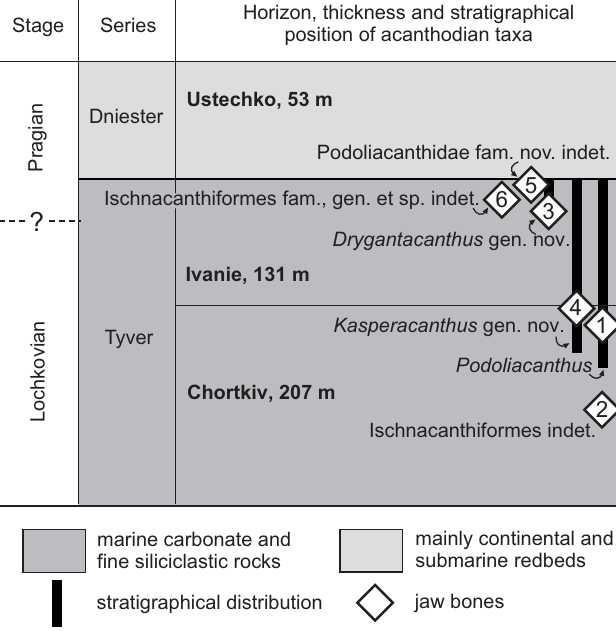
Fig. 2. Simplified stratigraphy of the marine Lower Devonian beds in Podolia showing distribution of Ischnacanthiformes jaw bones (modified from Drygant and Szaniawski 2012; Voichyshyn and Szaniawski